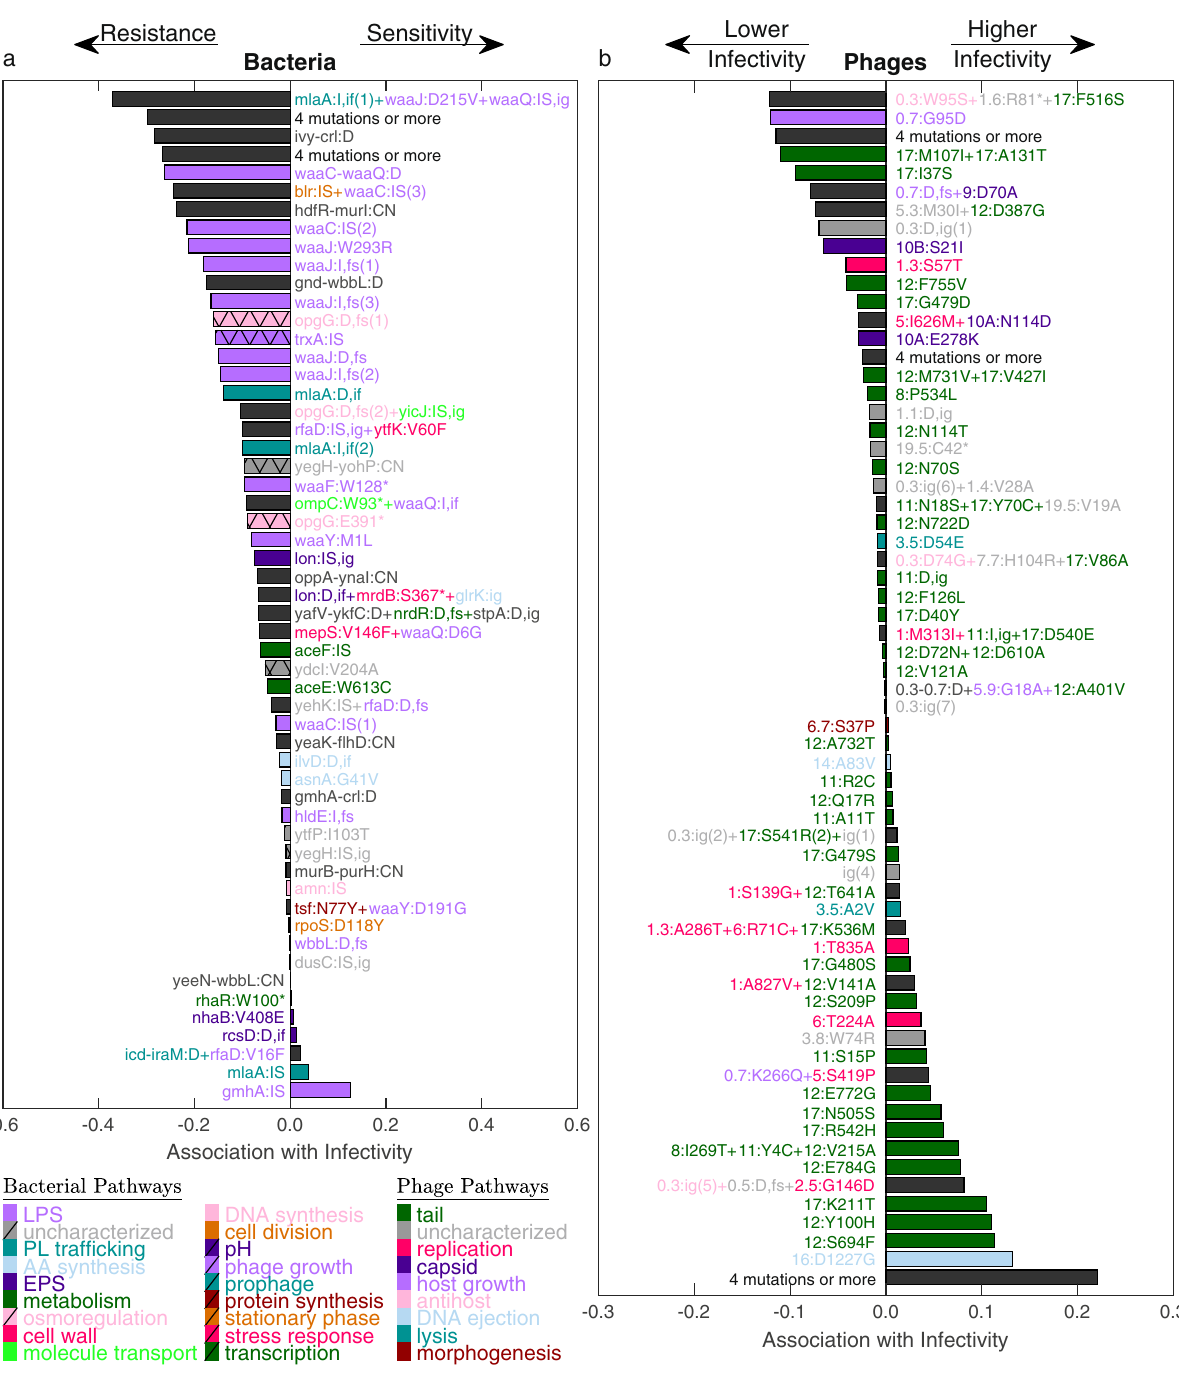
Fig. 3 | Lasso regression analysis identi fi es mutations affecting phage-bacteria interactions. Association of infectivity with mutations based on a joint regression model for all phage-bacteria interaction pairs, shown for all bacterial ( a ) and phage ( b ) mutations with non-zero Lasso coef fi cients. Bar colors represent the biological pathway of each mutated gene, with black bars indicating mutations affecting several genes of different biological pathways. AA - Amino acid, EPS - Exopolysaccharides, LPS-lipopolysaccharides,PL-phospholipid.Mutationsarelabeledaccordingtotheirtype:copynumbervariation(CN),deletion(D),insertion(I),insertionsequence(IS), intergenic (ig), inframe (if) and frame-shift (fs). Index (in parentheses) is added to different mutations with the same label. The numbers in the beginning of each phage mutationname( b )refertothephagegenenumber( “ gp ” wasomittedduetolimitedspace).Forexample,11:R2Crepresentsachangeinthesecondcodonofthephagetail tubular gene gp 11. Source data are provided as a Source Data fi